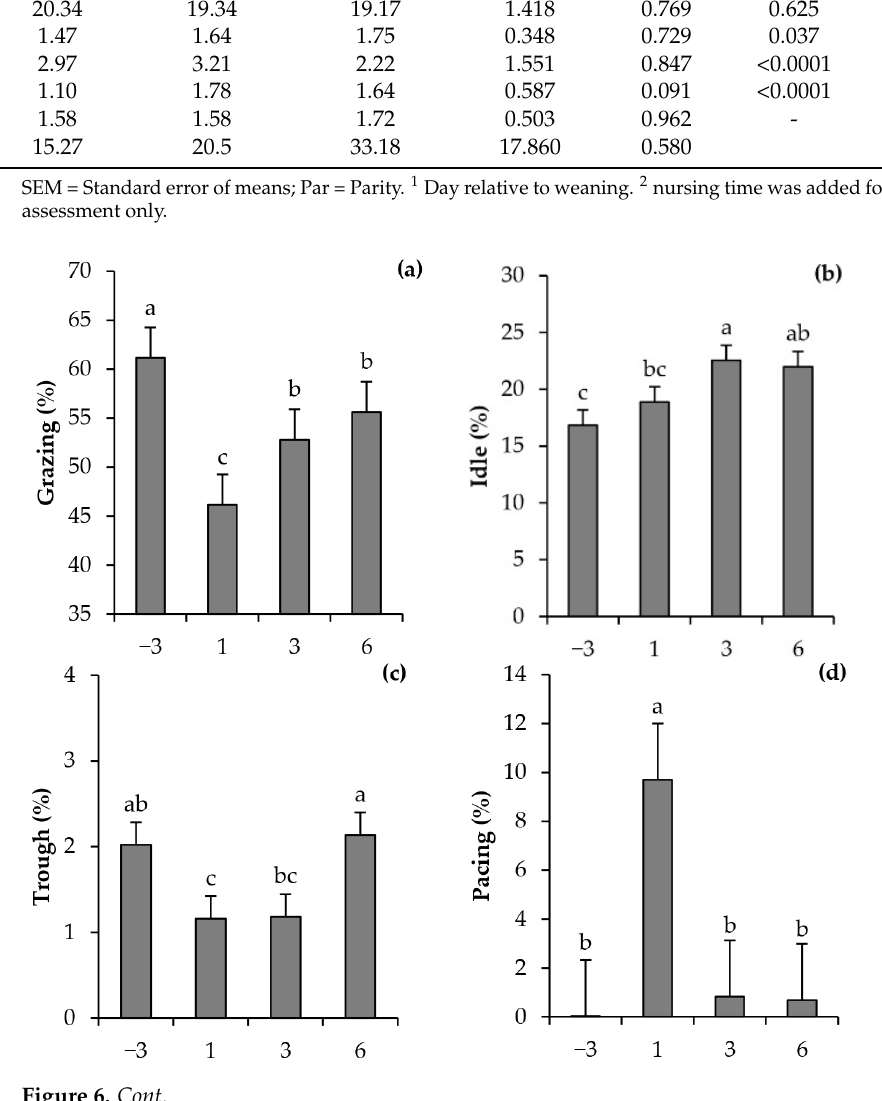
Figure 6. Grazing ( a ), idle time ( b ), trough time ( c ), pacing ( d ), and walking ( e ) in Nellore cows under grazing according to the days relative to weaning. Days with di ff erent superscripts di ff er from each other ( p < 0.05). Table 3. E ff ect of parity on behavior observation in Nellore cows at abrupt weaning. Parity